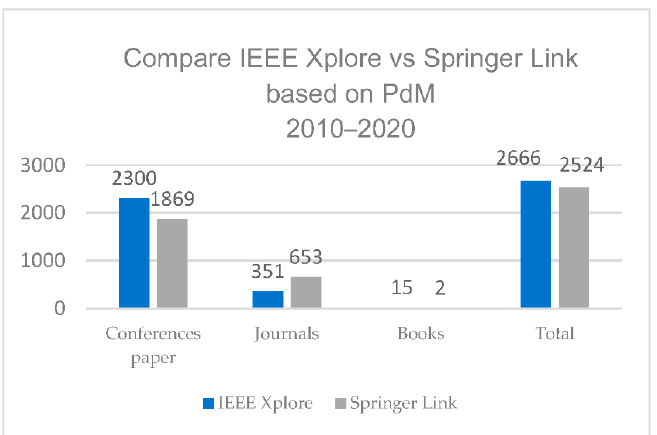
Figure 3. Compare IEEE Xplore vs. Springer Link studies based on PdM.